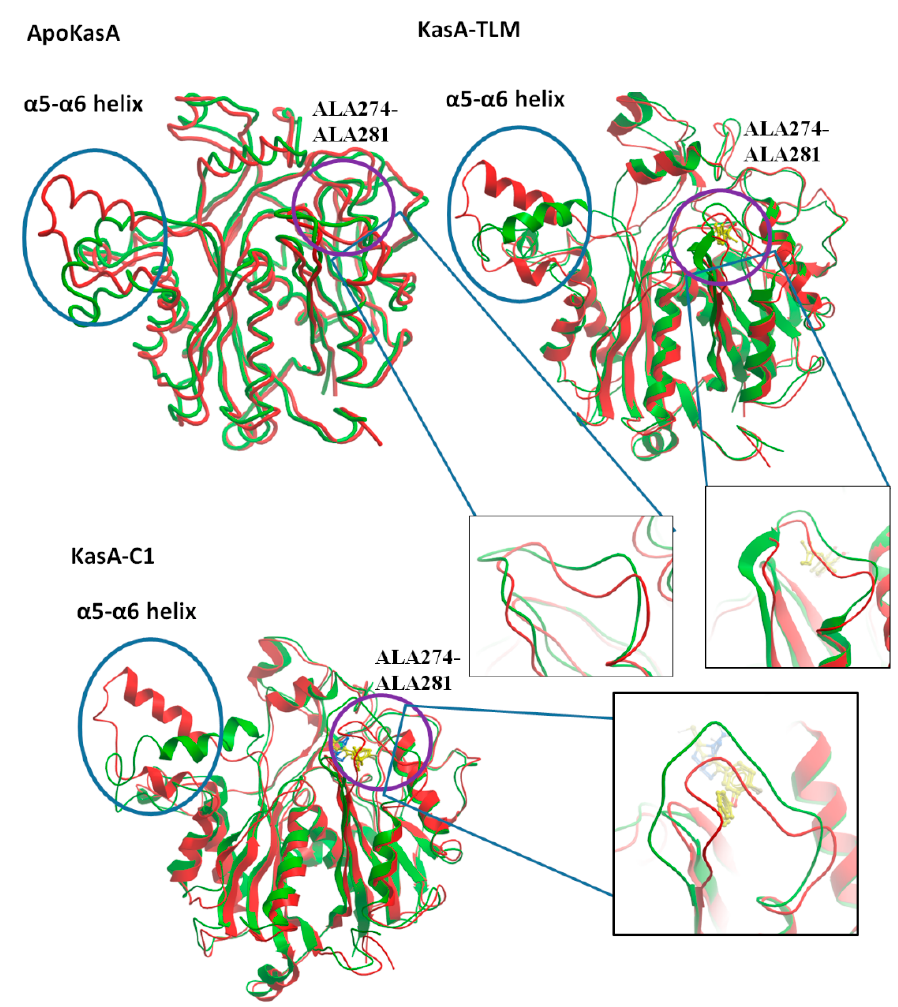
Figure 6. Structure alignment of MTB ApoKasA, KasA-TLM, and KasA-compound 1 (KasA-C1) before (red) and after (green) MD simulation. Two major areas of noticeable RMSD changes are the α 5– α 6 helix (encircled by blue circles) and ALA274–ALA281 (encircled by violet circles) and are further represented by additional insets.